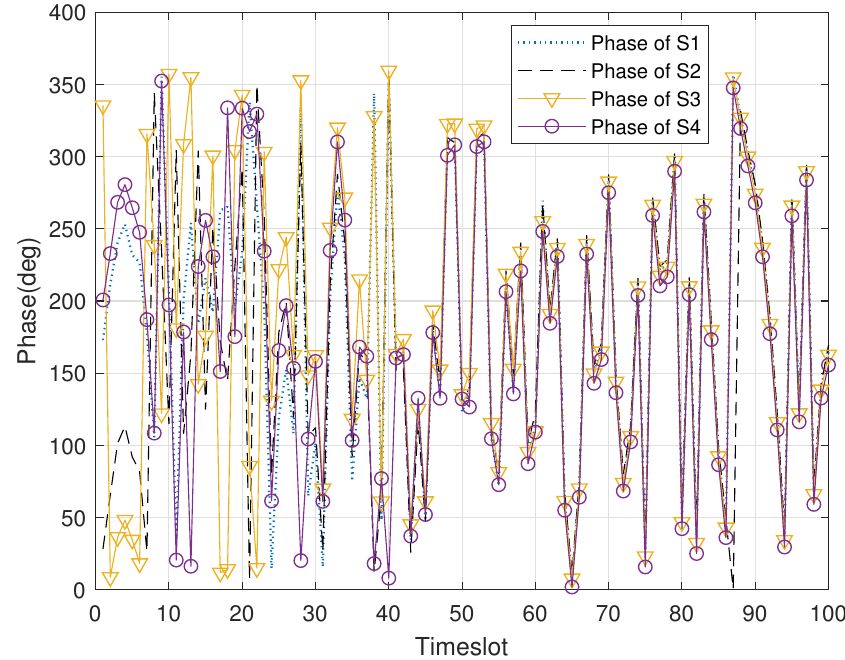
Figure 5. The signal phase of each concomitant satellite versus timeslot with RPC_TF algorithm. Next, the average convergence speeds of the proposed RPC_TF algorithm, the direc- tional perturbation feedback algorithm (DPA) in [21], and the modified hybrid algorithm (MHA) in [22] for the situation in which a sudden change occurs at timeslot t = 200 are depicted in Figure 6, where L = 4, γ = 0 dB, δ 0 = mum strength S EGC based on EGC is also given for comparison. It can be found that the S three algorithms can converge to γ EGC , and the error rate is less than 5%, which